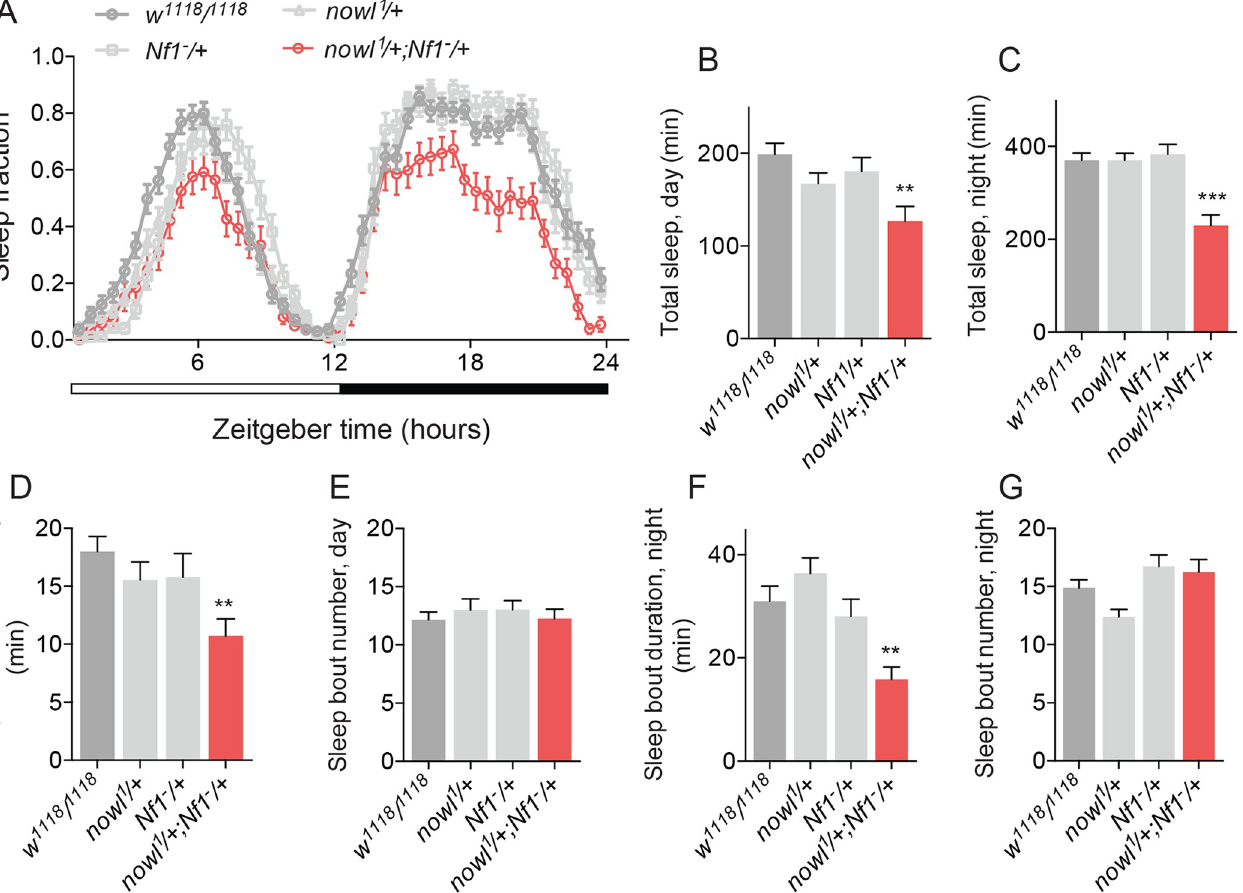
Fig 6. Interactions between nowl and Nf1 suggest that they act on a common sleep-regulatory mechanism. (A) Sleep patterns of heterozygous nowl 1 /+ and Nf1 - /+ females show that one copy of each is sufficient for maintaining proper sleep, while the trans-heterozygous ( nowl 1 /+ ; Nf1 - /+ ) mutants exhibit decreased sleep during both day and night. (B-G) Quantification of sleep parameters shows reduced average sleep-bout duration of trans-heterozygous nowl 1 /+; Nf1 - /+ females, indicating that nowl and Nf1 interact to maintain sleep. Graphs represent means with SEM (n = 32) of data from one experiment. Significance was determined using Kruskal-Wallis test with Dunn’s post-hoc testing ( � p < 0.05, �� p < 0.01, ��� p <